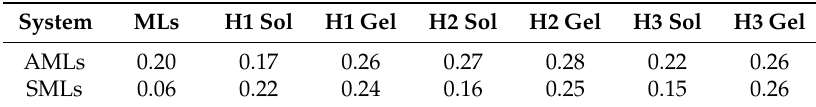
Table 2. Steady-state fluorescence anisotropy ( r ) values of Nile Red for gels with the incorporated AMLs or SMLs. Values in neat magnetoliposomes (MLs) are shown for